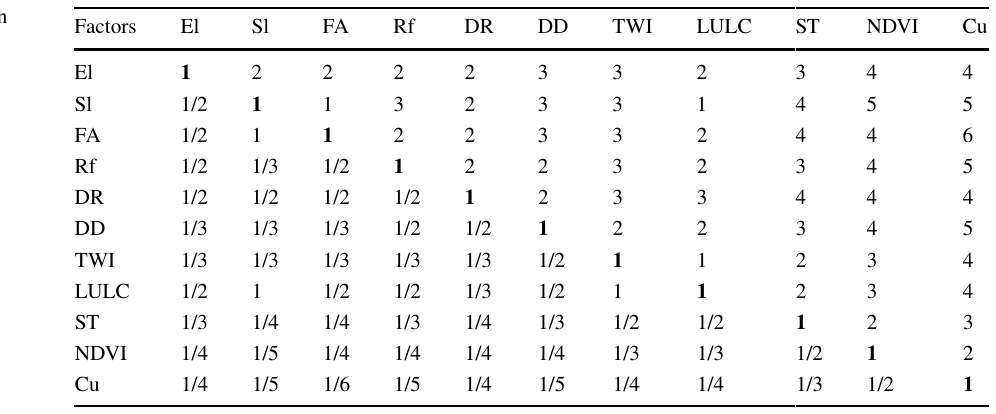
Table 4 Normalized pairwise comparison matrix and calculated criteria weight for each factor